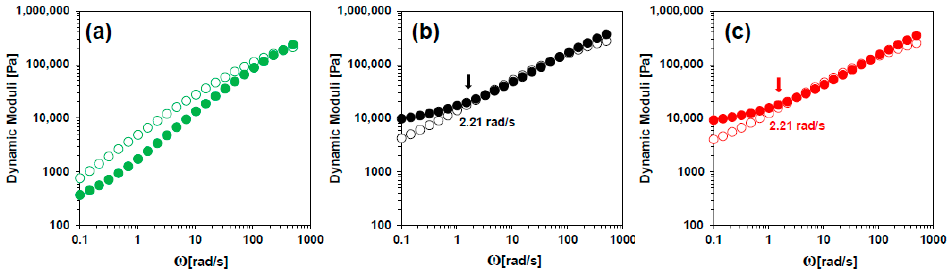
Figure 9. Loss modulus (G ′′ ) (open symbols) and storage modulus ( G ′ ) (solid symbols) of N-MWNTs/PVDF nanocomposites containing 3.0 wt.% of carbon nanotubes synthesized on different catalyst concentrations for strain amplitudes of 1% using parallel-plate geometry at a gap-size of 0.3 mm at 210 °C. ( a ) PVDF/N-MWNTs synthesized with 10 wt.% Fe, ( b ) PVDF/N-MWNTs synthesized with 20 wt.% Fe, and ( c ) PVDF/N-MWNTs synthesized with 40 wt.% Fe. Arrows represent the location of second crossover points ( G ′′ = G ′ ).